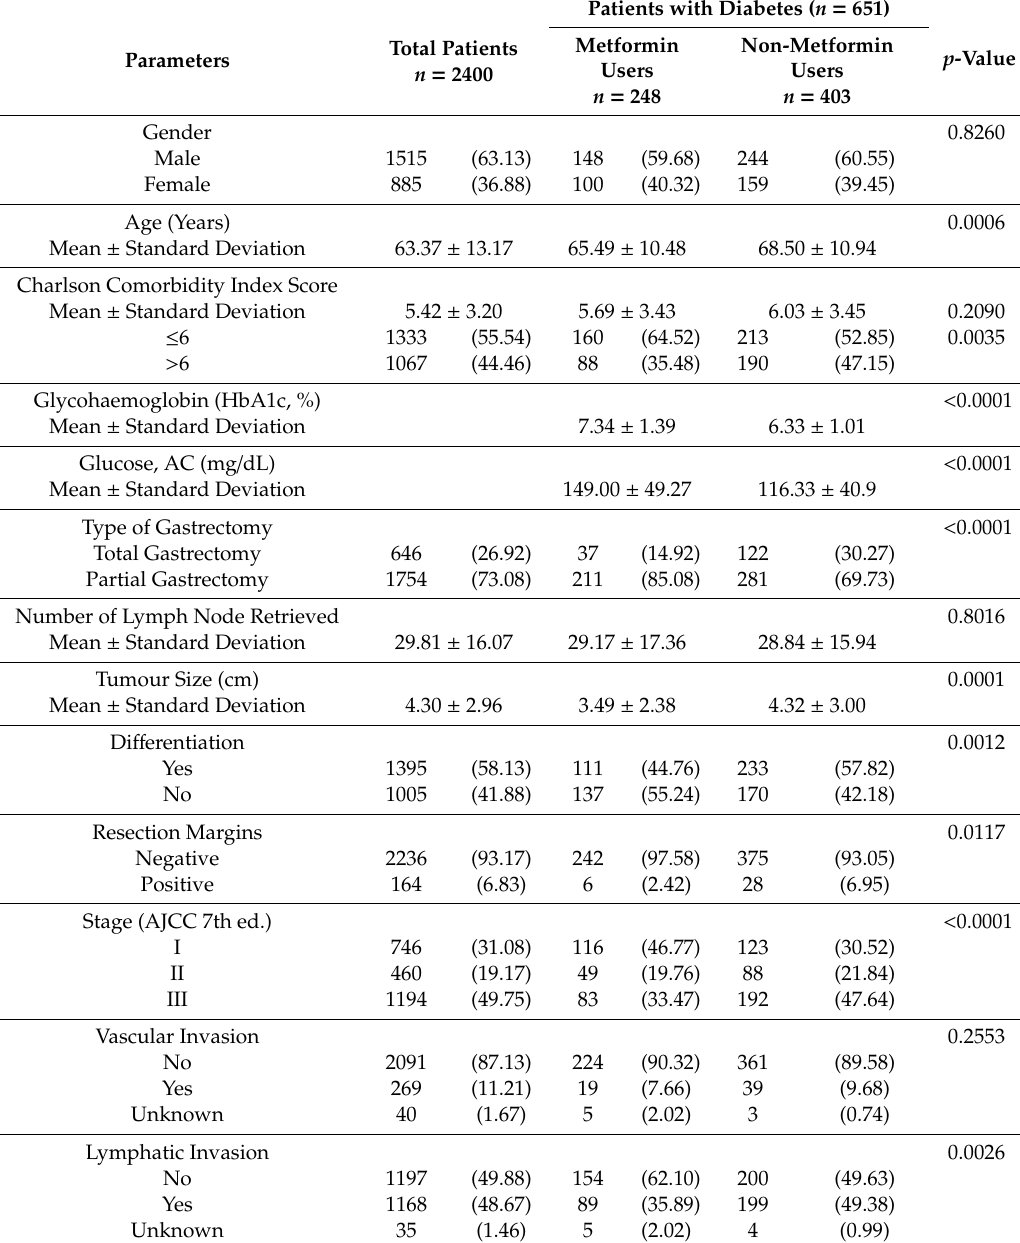
Table 1. Clinicopathological characteristics of patients with stage I-III